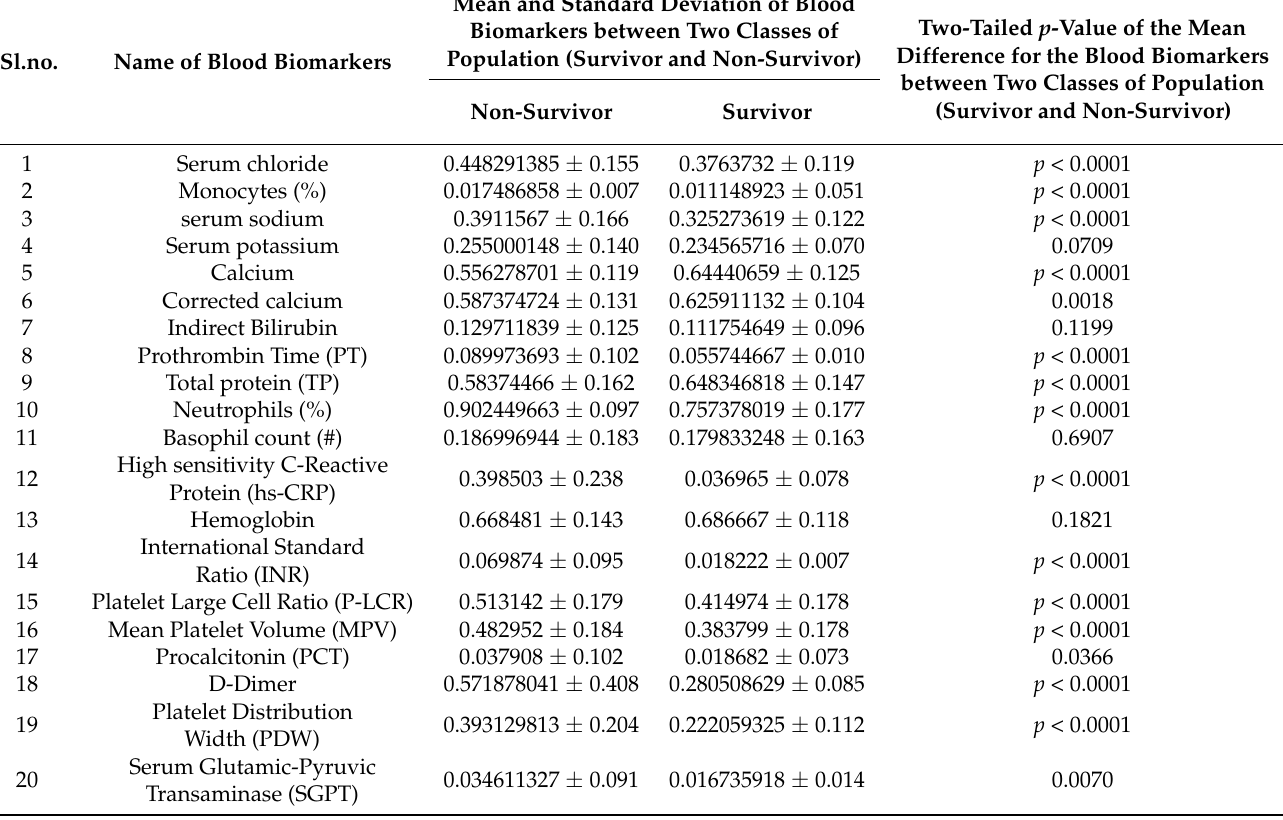
Table 3. List of features (blood biomarkers) obtained using mRMR and the corresponding mean difference between two classes of population (survivor and non-survivor) at a significance level of